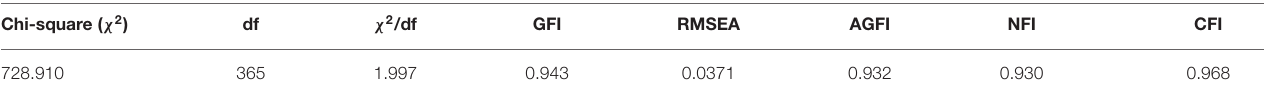
TABLE 5 | Model fitting